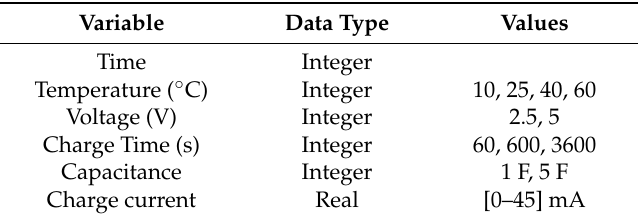
Table 3. Variables used for the development of the prediction